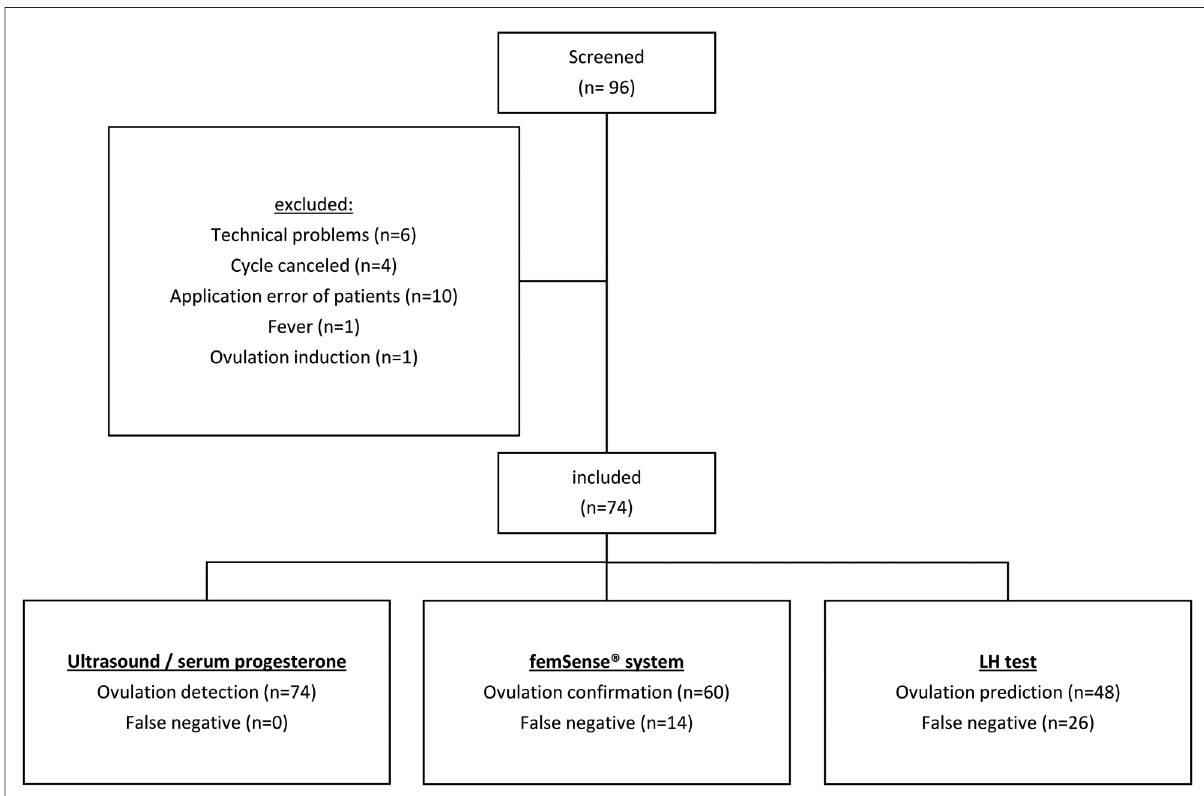
FIGURE 2 Study population fl ow chart: after screening 22 out of 96 participants were excluded. Ultrasound together with serum progesterone detected 74 ovulations, the femSense ® system con fi rmed 60 and the urinary LH test predicted 48 ovulations,